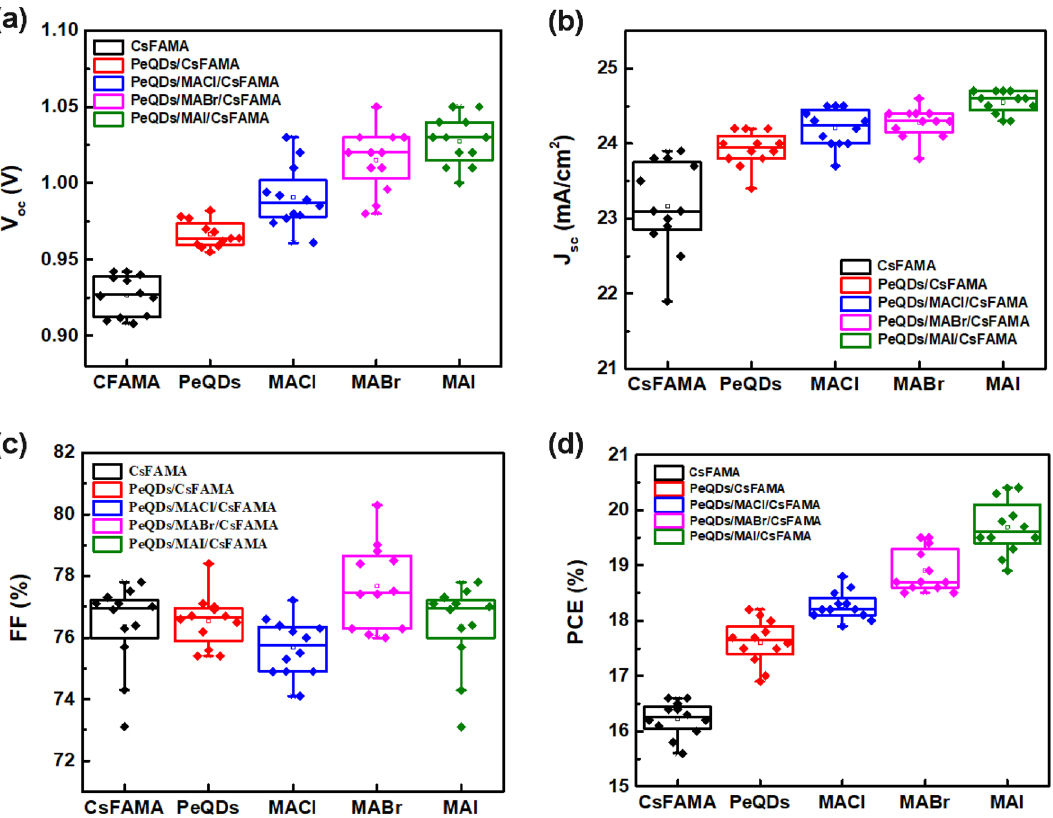
Figure 6. Statistical distribution of ( a ) Voc, ( b ) Jsc, ( c ) FF, and ( d ) PCE of the PeSCs based on the CsFAMA, PeQDs/CsFAMA, and PeQDs/MAX (Cl, Br,